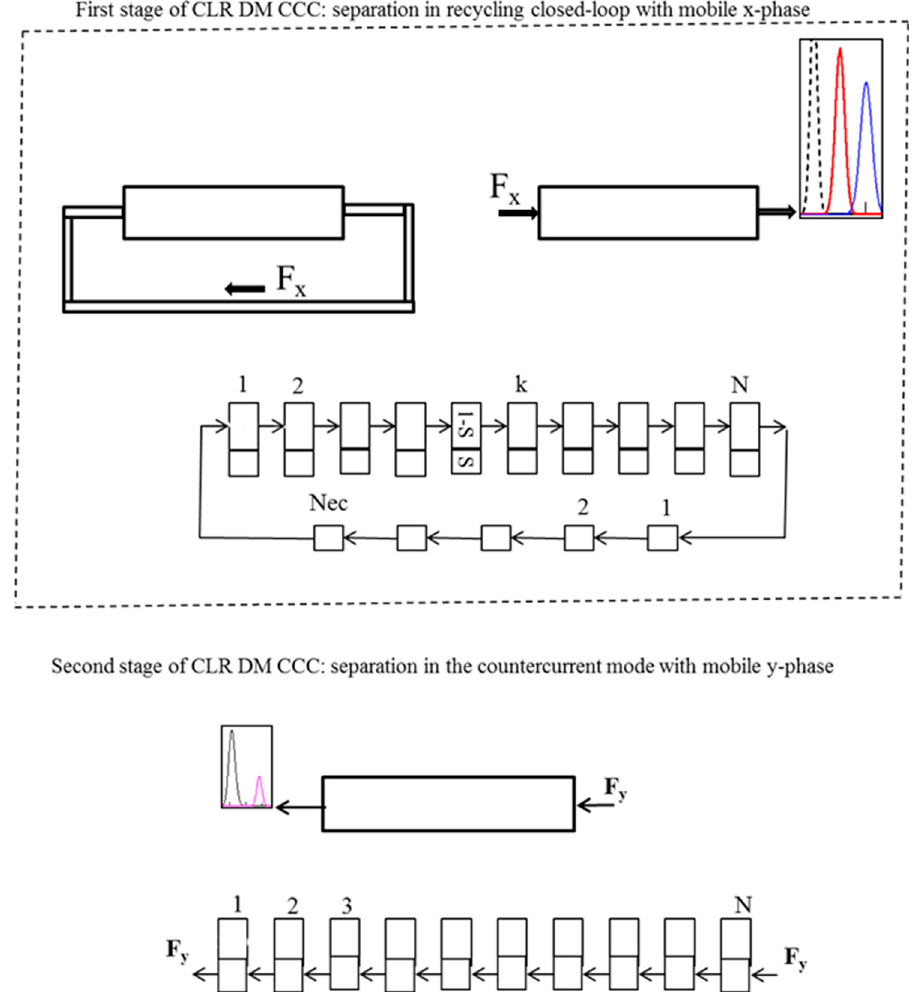
Figure 9. Schematic diagram of the closed-loop recycling dual mode countercurrent chromatography separations and the applied mathematical model.